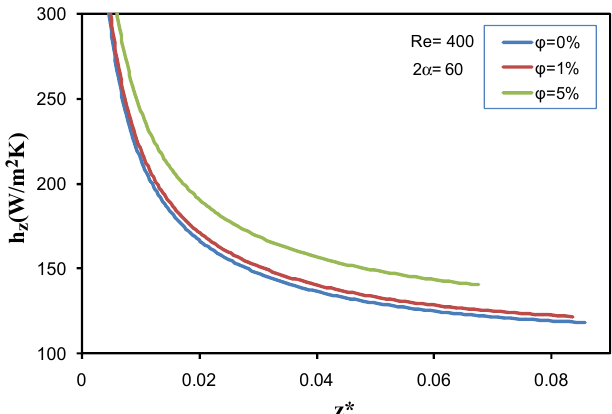
Fig. 4. Local heat transfer coefficient of nanofluids vs. axial position for different nanoparticle concentrations.